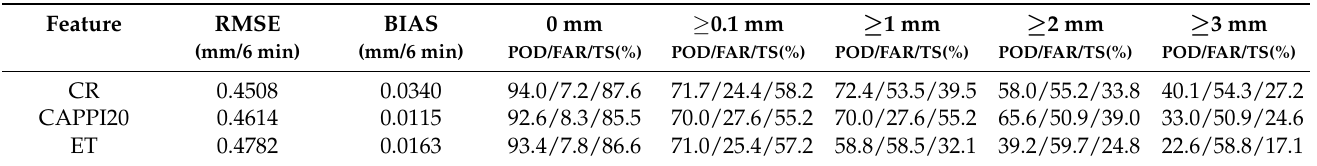
Table 5. Comparison of using single radar feature as